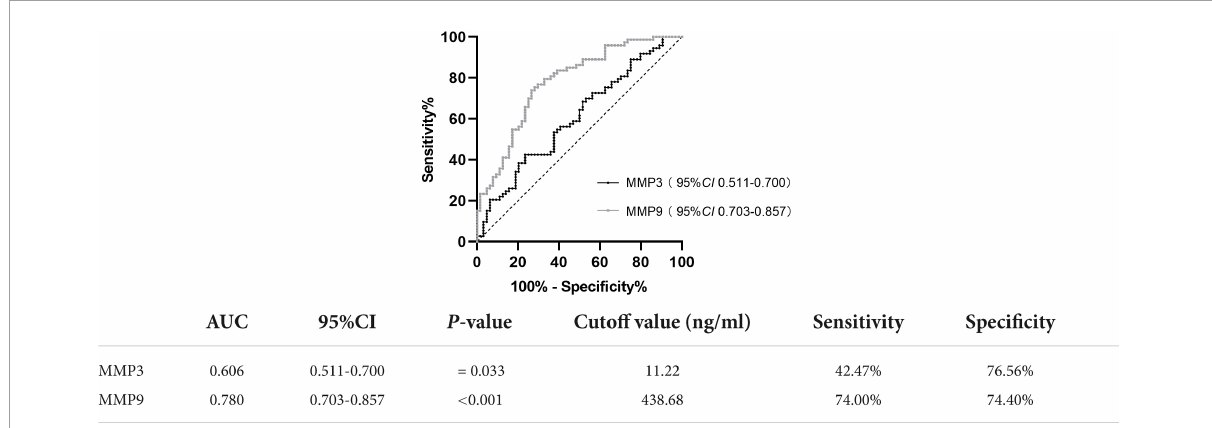
FIGURE2 ROC curve for serum MMP3 and MMP9 levels comparing the PD group and healthy control group. ROC curve, receiver operating characteristic curve; AUC, area under the curve; CI, confidence interval.